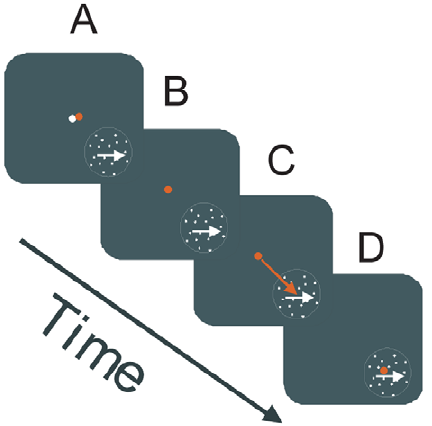
Figure 1. Task Design. A. Monkeys fixated a central fixation point (white dot) and a translating pattern of dots appeared in the lower visual field, either to the left or right of fixation. Rye position is indicated by the red dot. B. After a variable period (500–1500 ms), the fixation point disappeared. C. Upon fixation point offset, the monkey saccaded to the aperture. D. If the saccade occurred within 300 ms of fixation offset, reward was delivered 200 ms after the end of the saccade, during which time the eye movements are